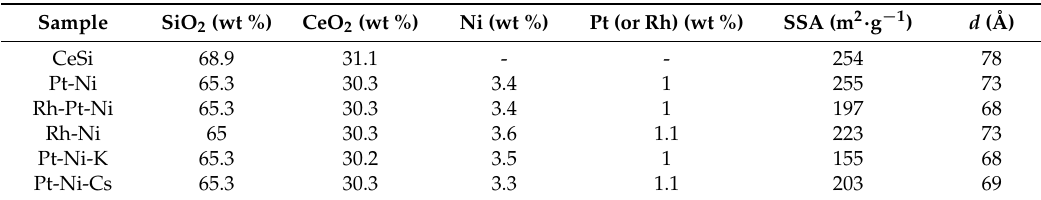
Table 1. Chemical composition, CeO 2 crystallite sizes ( d ), and specific surface area of the calcined samples.